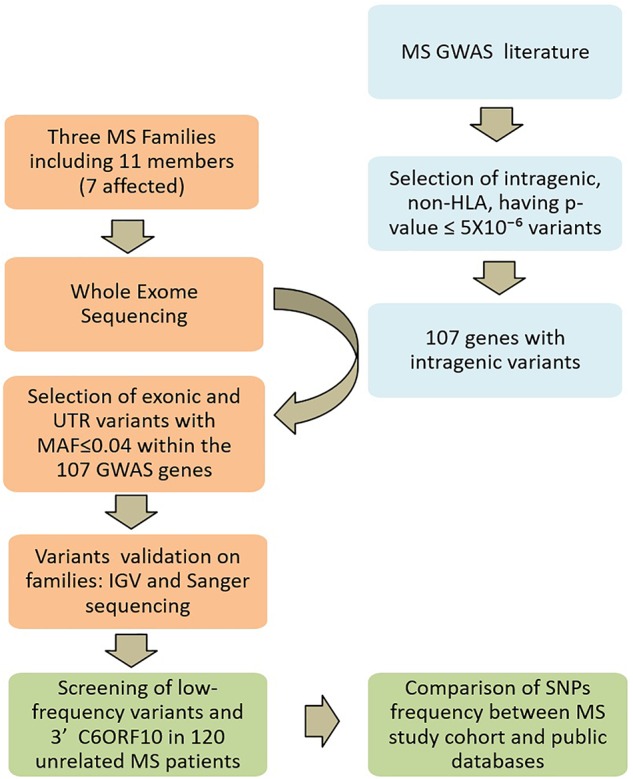
Study design. Multiple sclerosis (MS) GWAS and WES SNP filtering is schematically described. In light blue, the search strategy and selection criteria of candidate genes; in orange the Whole-exome sequencing and the analysis on MS families; in green the screening strategy in the unrelated MS patients.